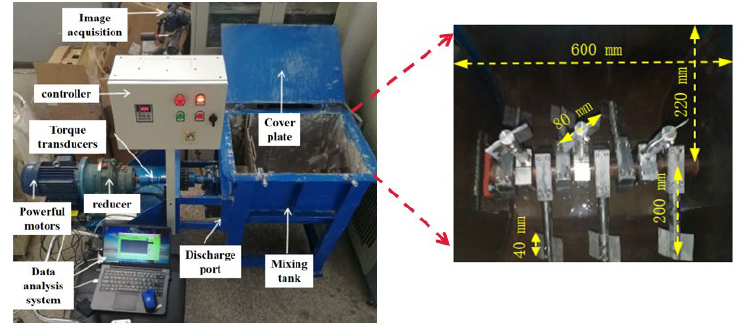
Figure 2. Laboratory mixer and its internal